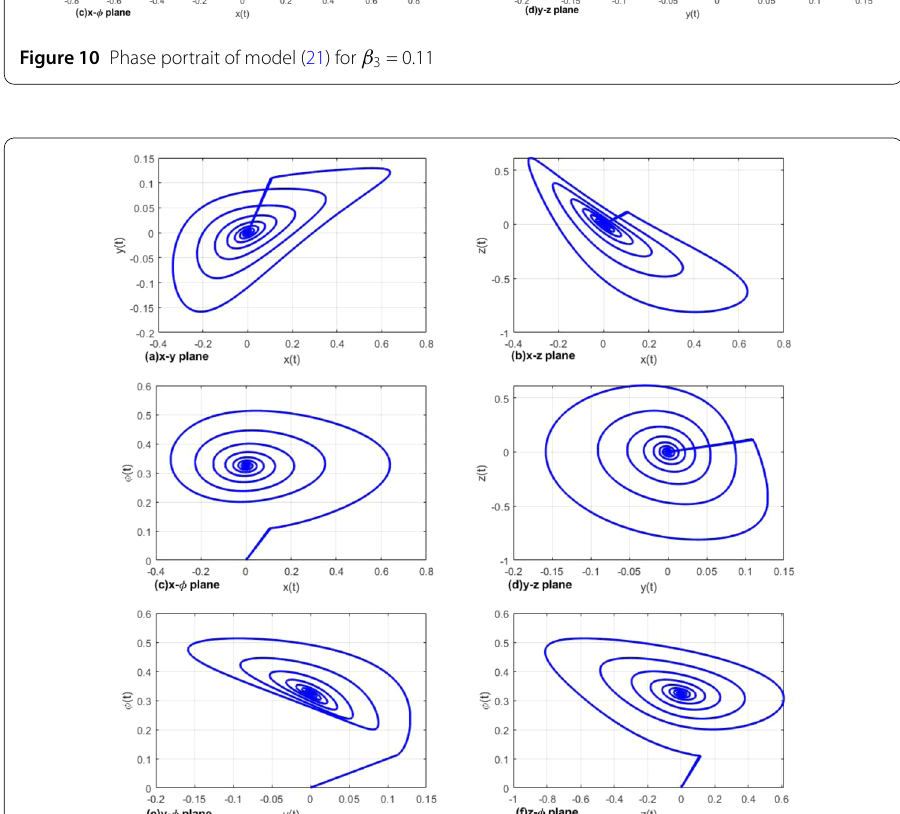
Figure 11 Phase portrait of model (21) for β 3 =